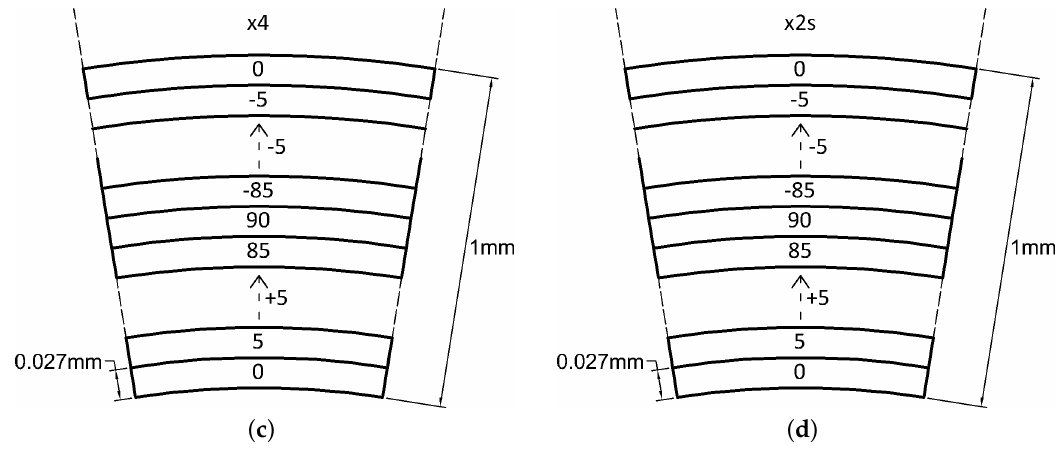
Figure 11. ( a ) L .1 laminate, ( b ) L .2 laminate, ( c ) L .3 laminate and ( d ) L .4